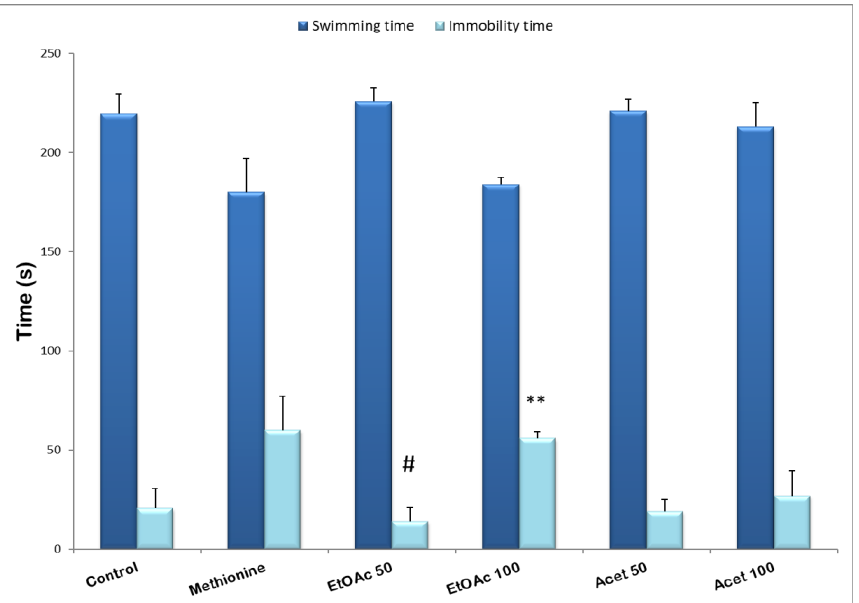
Figure 4. The antidepressant effect of the extracts of carob seed peels extracts (50 and 100 mg/kg) on immobility time and swimming time in mice. Data represent the mean ± SEM ( n = 4 – 6 animals) with ** p ≤ 0.01 vs. control and # p ≤ 0.05 vs. Methionine groups.